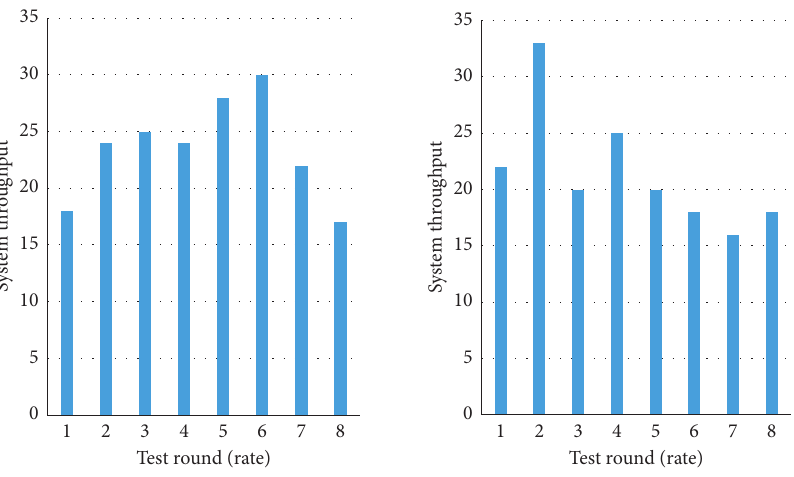
Figure 3: Performance test